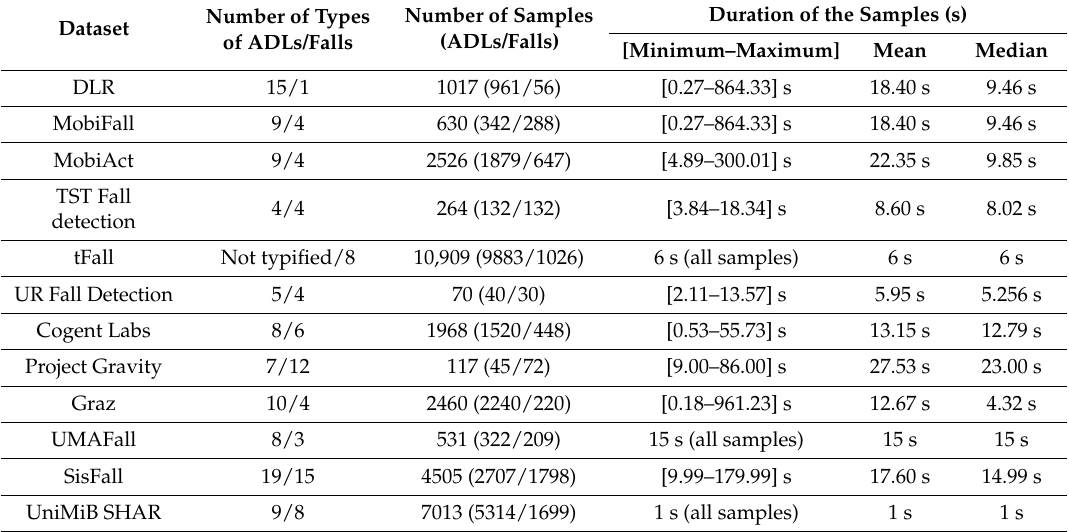
Table 5. Number, typology and duration of the samples in the